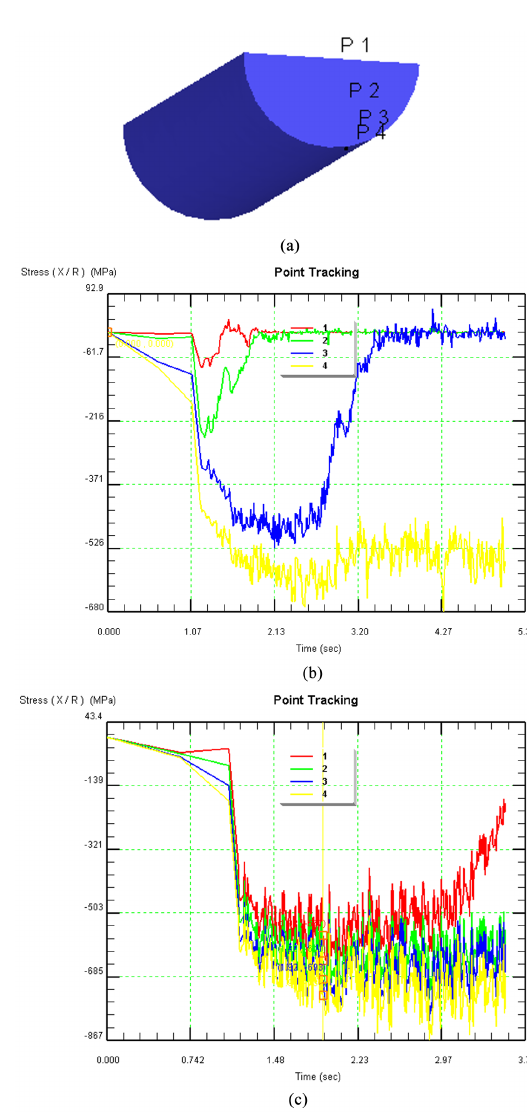
Figure 5. The axial stress along the extrusion direction varying with extrusion time at the surface point of the rod with points (a) for ES extrusion with the ratio of 11.6 (b) and 28